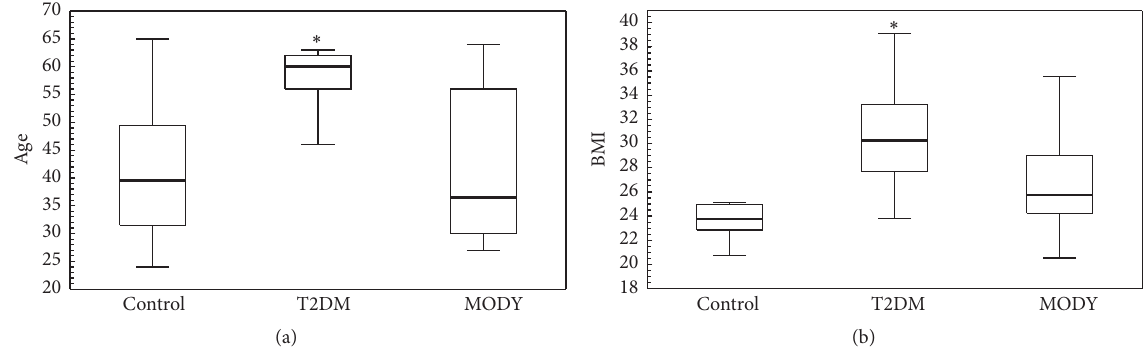
Figure 1: Comparison of age and BMI between groups. To reveal differences in age and BMI, the Kruskal-Wallis test was performed. Data presented as median (first–third quartiles). BMI: body mass index; MODY: Maturity Onset Diabetes of the Young; T2DM: type 2 diabetes mellitus. (a) Median age in the first control group was 39.5 (31.5–49.5) years, in HNF1A-MODY was 36.5 (30–56) years, and in T2DM was 60 (56–62) years. There was no difference in age ( 𝑝 = 1.0000 ) between HNF1A-MODY and the first control group. The T2DM group was older than the first control group ( 𝑝 = 0.0006 ) and HNF1A-MODY group ( 𝑝 = 0.0133 ). (b) Median BMI in the first control group was 23.77 (22.85–24.95) kg/m 2 , in HNF1A-MODY was 25.74 (24.22–29 kg/m 2 ), and in T2DM was 30.25 (27.68–33.25) kg/m 2 . There was no difference with respect to BMI ( 𝑝 = 0.2600 ) between HNF1A-MODY and the first control group. The T2DM group was characterized by higher BMI than control group ( 𝑝 = 0.0000 ) and HNF1A-MODY group ( 𝑝 = 0.0290 ). ∗ indicates that there was a significant difference between this group and control